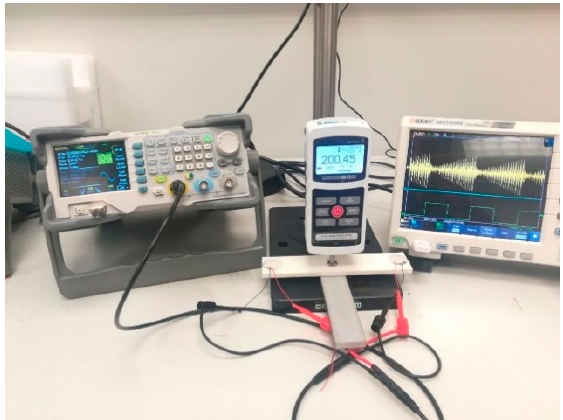
Figure 3. Experimental setup.